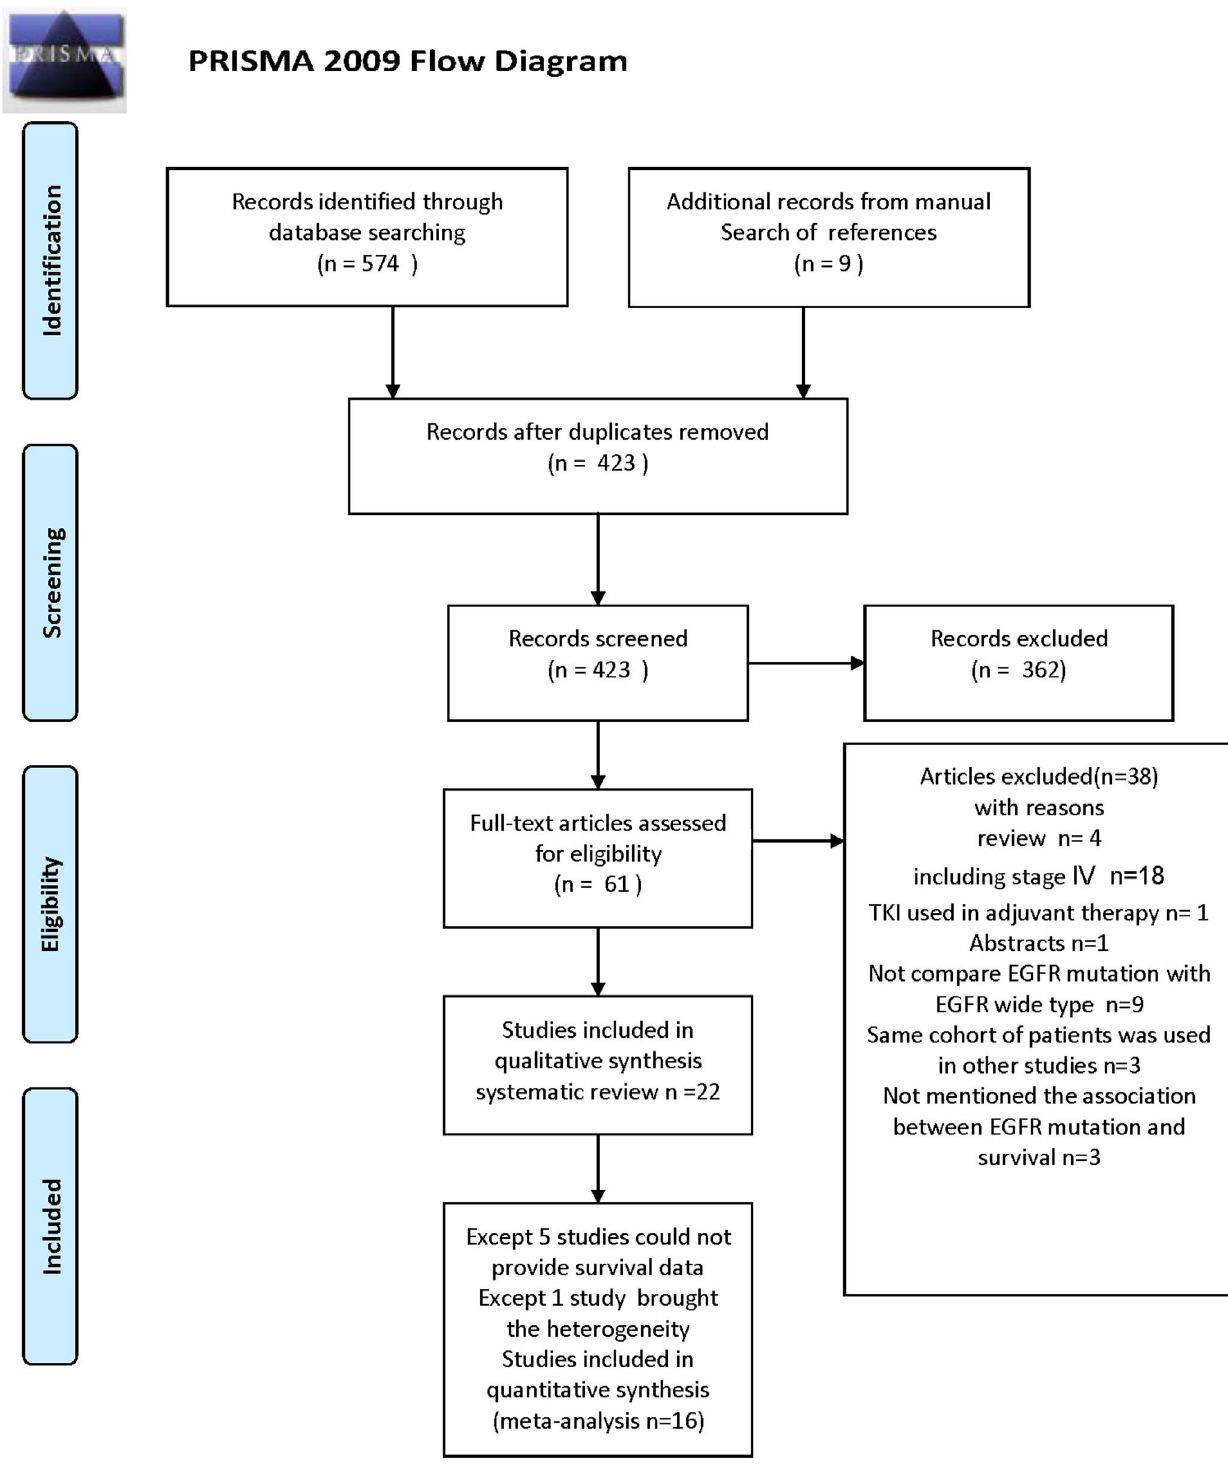
Figure 1. PRISMA Flow chart of the search result of the meta-analysis. doi:10.1371/journal.pone.0106053.g001 prognostic factor. 19 studies reported EGFR gene mutations were not a prognostic factor for survival. For detecting mutations of EGFR gene, PCR and direct sequencing were used.